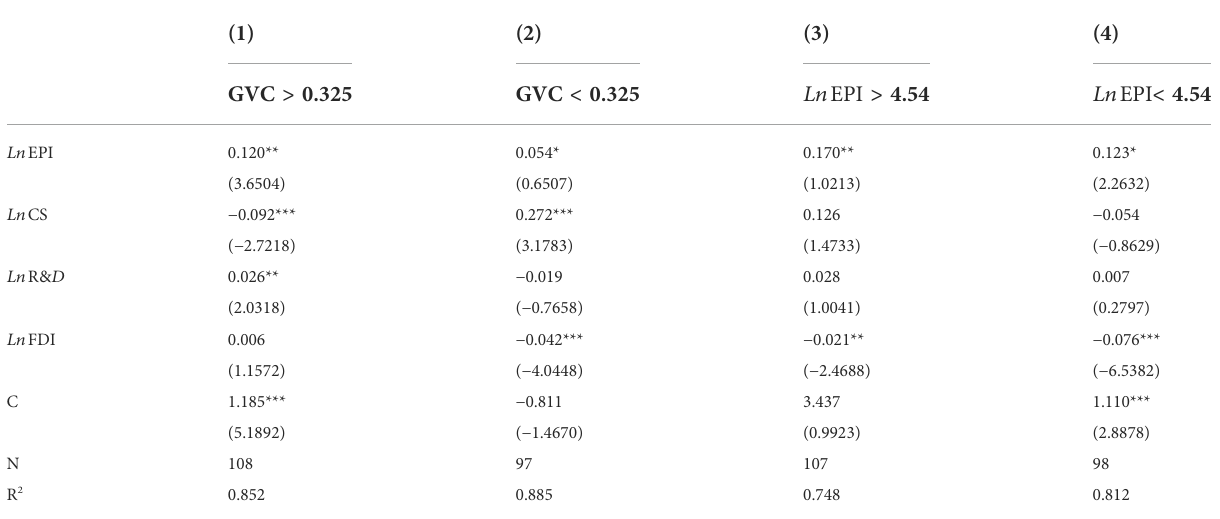
TABLE 6 Quantile regression results.